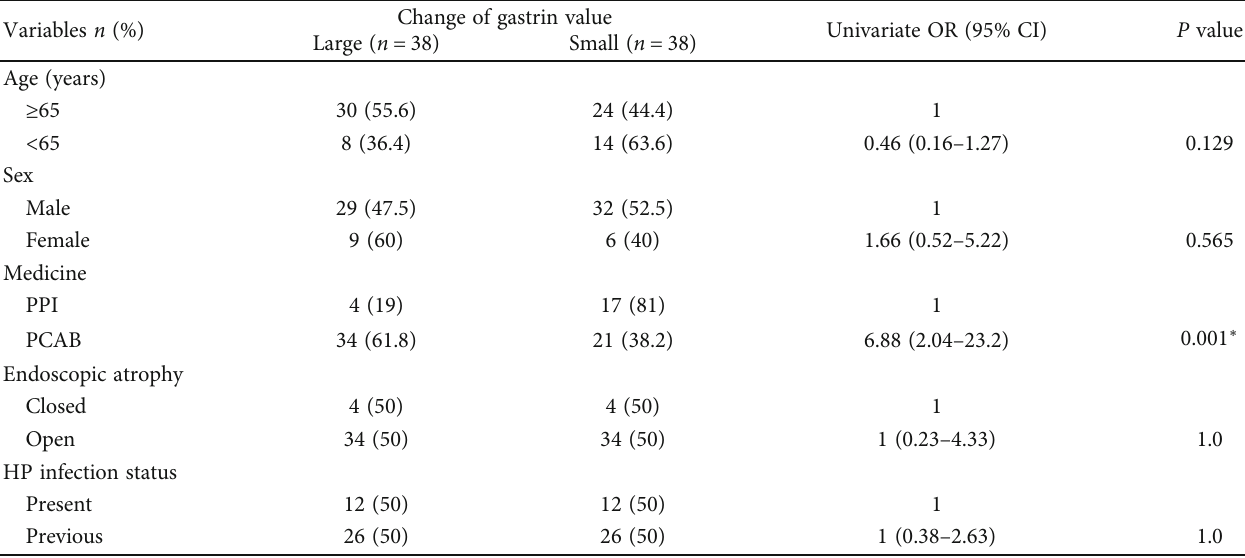
Figure 3: Comparison of serum G17 levels before and after proton pump inhibitor (a) and potassium competitive acid blocker administration (b). Correlation between serum gastrin level and G17 level (c). Table 3: Univariate analysis of the host factors that contribute to serum gastrin level